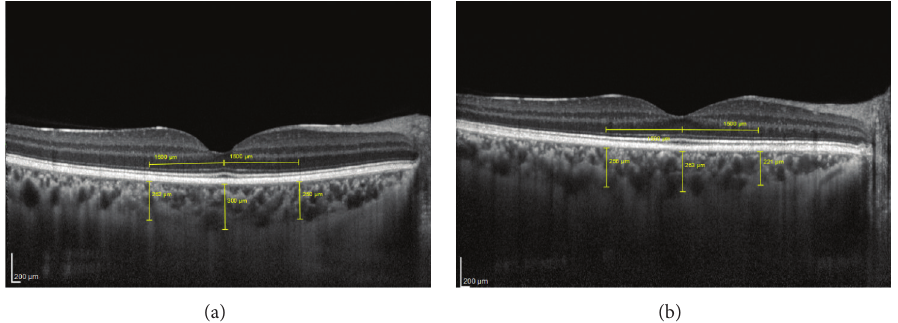
Figure 1: (a) shows picture of the scanning imaging obtained from control’s choroid thickness. (b) shows picture of the scanning imaging obtained from migraineur’s choroid